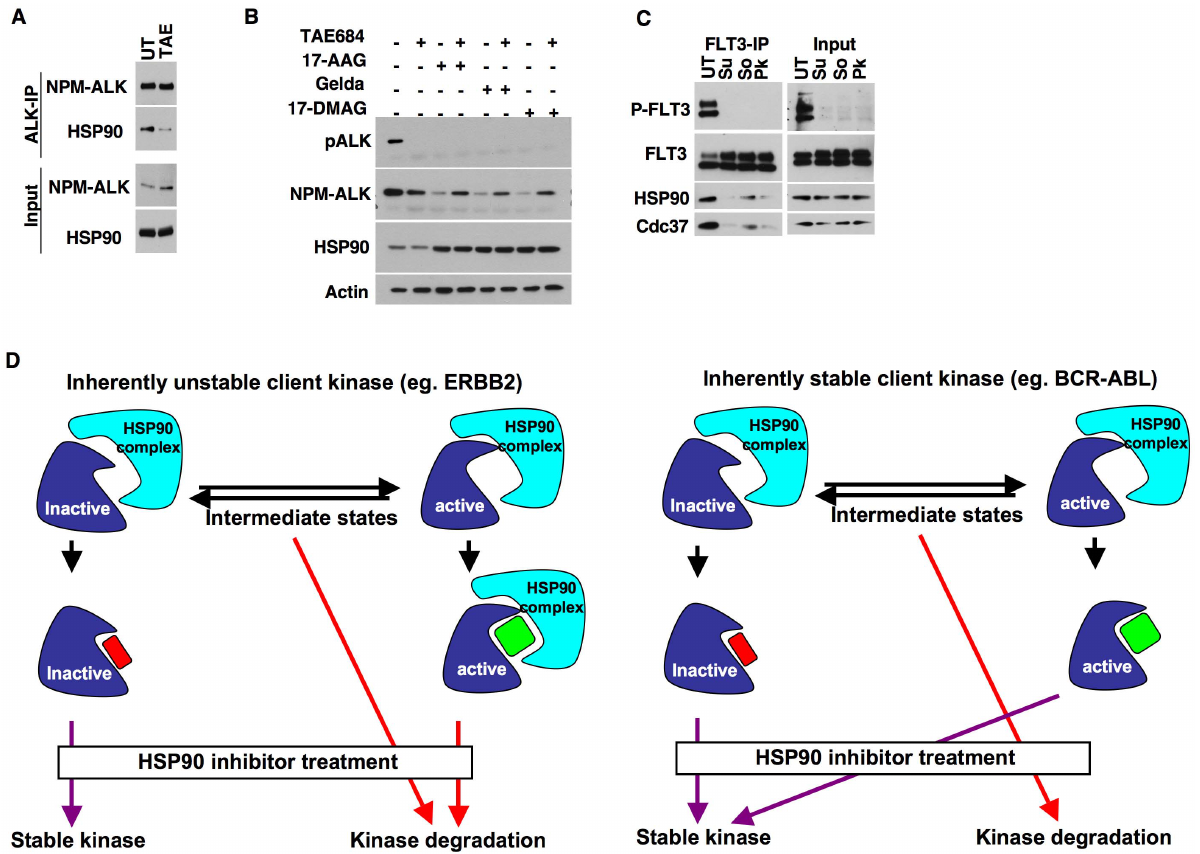
Figure 4. The impact of an active kinase conformation on HSP90 interaction varies between oncogenic tyrosine kinases. (A) KARPAS cells were treated with 0.1 m M of TAE-684 for 2 hours. Cells were then lysed in TMNSV buffer followed by immunoprecipitation and immnoblotting with indicated antibodies. (B) KARPAS cells[13] were treated with 0.1 m M of TAE684 followed by HSP90 inhibitor treatment (1 m M of geldanamycin, 17-AAG or 17-DMAG) for 22 hours. Cells were then lysed and western blotting was performed to analyze NPM-ALK degradation. (C) Ba/F3-FLT3-ITD cells[11] were treated with 1 m M of sunitinib (Su), sorafenib (so) or PKC412 (Pk) for 2 hours. FLT3 immunoprecipitates were then analyzed for the interaction with HSP90 and Cdc37. (D) Possible mechanism underlying client kinase degradation by HSP90